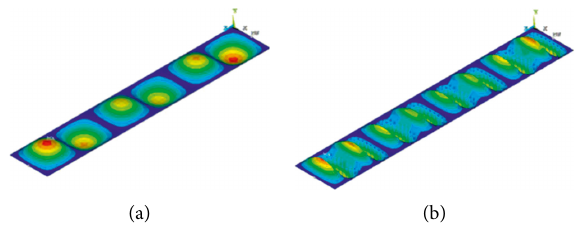
Figure 12: Buckling mode of unbraced (a) and braced (b) internal compressed plates ( b / t � 50).